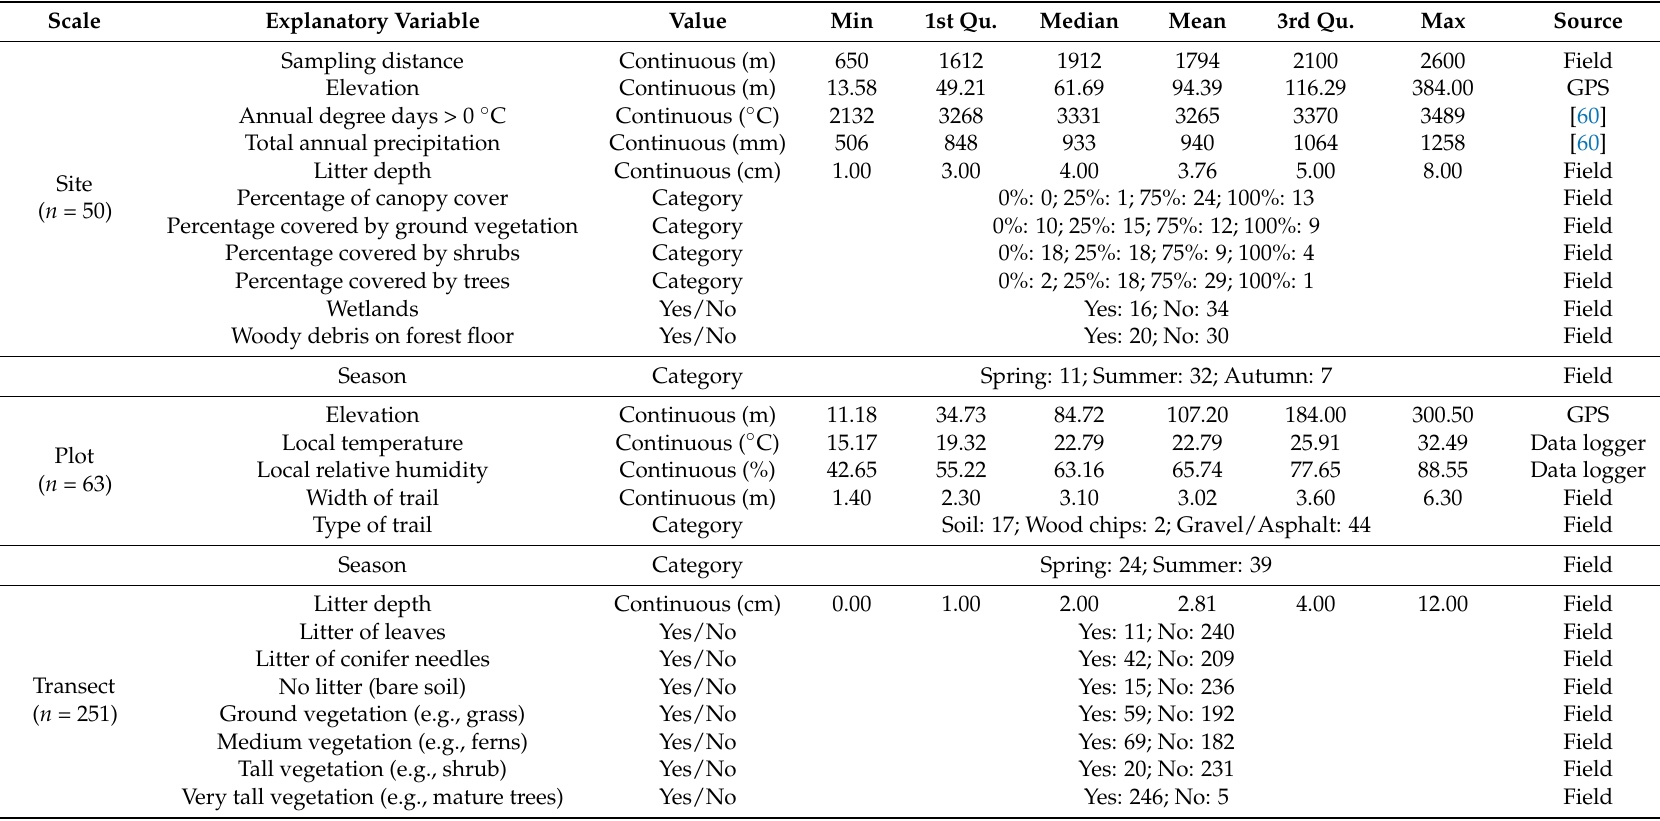
Table 1. Description of environmental variables used in regression models by geographic